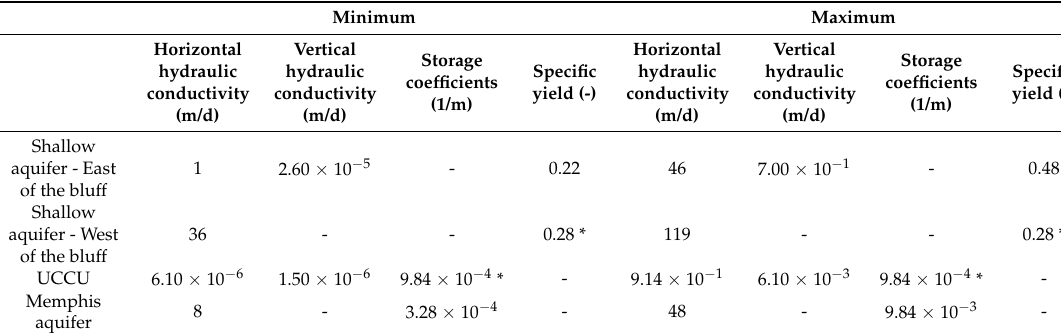
Table 1. Minimum and maximum of hydraulic parameters reported in previous studies within and nearby the study area [3,39,41–46].